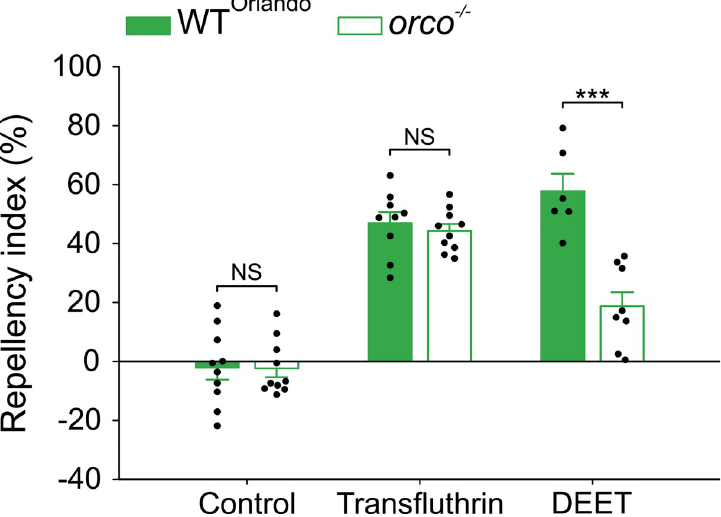
Fig 3. Transfluthrin repellency does not requires activation of Ors in Ae . aegypti . Repellency by 1 ppm of both transfluthrin and DEET in Orlando and orco -/- mosquitoes; Student’s t -test, control: t = 0.05, df = 18, P = 0.963, transfluthrin: t = 0.64, df = 17, P = 0.530, DEET: t = 5.17, df = 12, P < 0.001, NS = not significant, ��� P < 0.001; n values for: both controls and transfluthrin in orco -/- = 10, transfluthrin in Orlando = 9, DEET in Orlando = 6, and DEET in orco -/- = 8. The controls represent the baseline activity in response to the solvent; Data are presented as mean ± SEM. Dots over the bars represent individual replicate values.